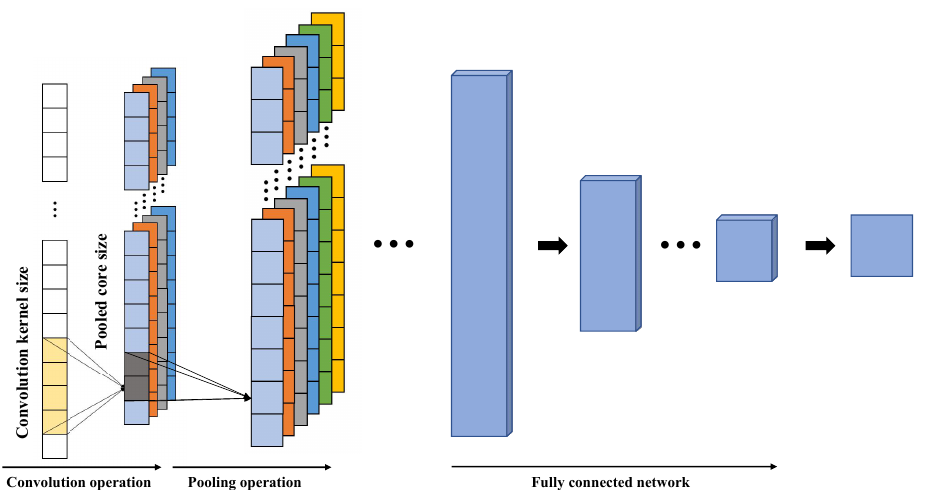
Figure 6. Structure of convolutional neural